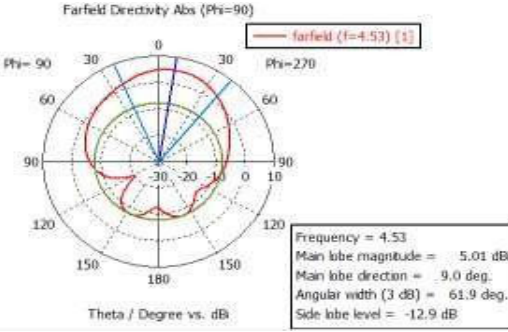
Figure 4.3: Farfield radiation pattern for 4.53GHz.